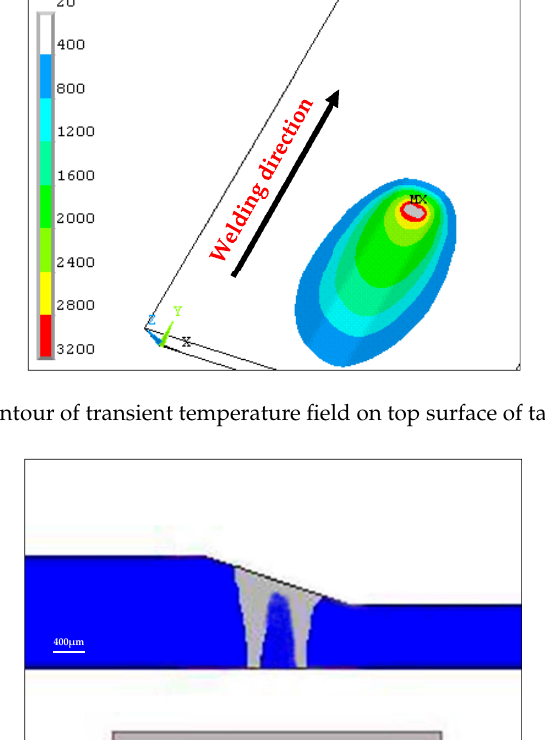
12 Figure 14. The calculated weld cross-section of the tailored blanks cross-section (2:1 power ratio, 1800 W total power, and 1.2 m/min welding speed): ( a ) The arrangement mode II ( b ) the arrangement mode III. 4.3. Temperature Field Characteristic Due to the unique heat transfer mechanism of dual-beam laser welding process and different thicknesses of tailored blanks, the distribution of temperature field had its own characteristics and should be obviously different from that of the common welding process. While the dual-beam laser with 1800 W total power and 2:1 power ratio was focused, respectively, on the thick plate and thin plate as showed in Figure 13, meanwhile the welding speed was 1.2 m/min. The contour of transient temperature field on the top surface of tailored blanks during dual-beam laser welding process was given in Figure 15. It can be seen that the fusion zone and heat